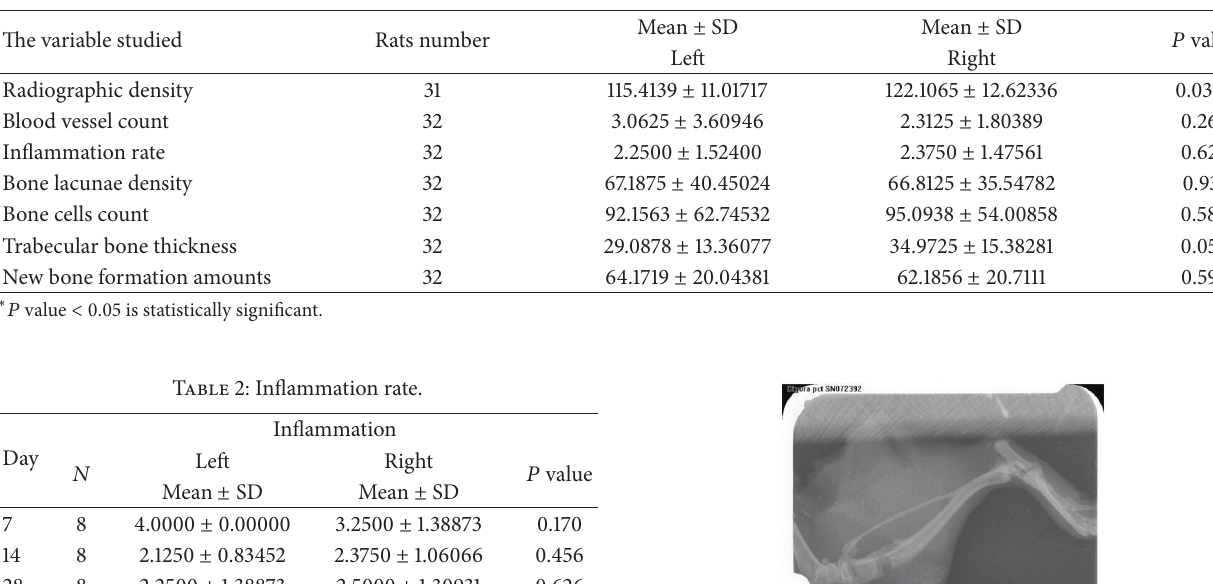
Table 1: Radiographic density, inflammation rate, blood vessel count, bone lacunae density, bone cell count, trabecular bone thickness, and new bone formation amounts for each sample.